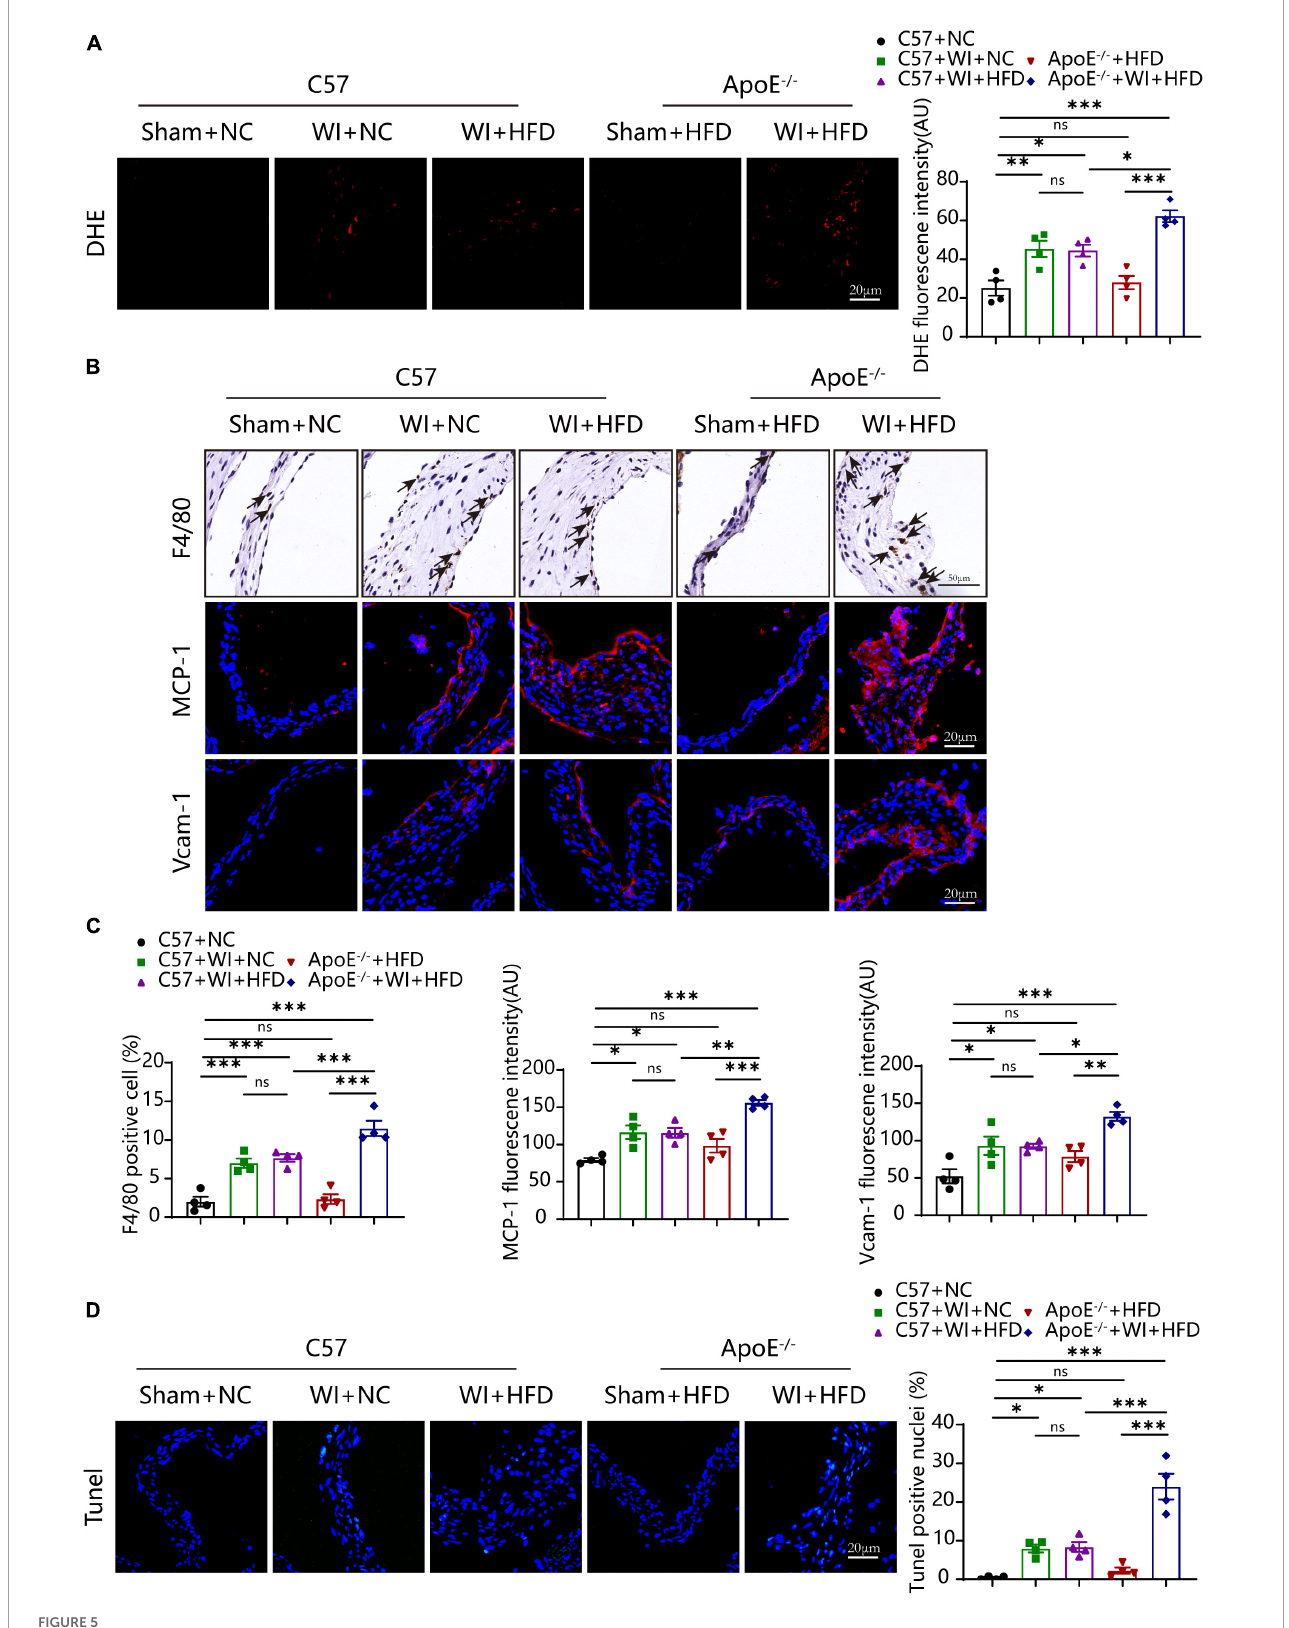
FIGURE5 Hyperlipidemia augmented advanced superoxide reaction and inflammation. Hyperlipidemia exacerbated superoxide (DHE, red, scale bar, 20 µ m); (A) after wire injury. Hyperlipidemia induced increment of macrophage accumulation beneath the leaflets endothelial (scale bar, 50 µ m) after wire injury and resulted in a pro-inflammatory valvular with increased expression of the chemokine MCP − 1 and Vcam − 1 (red, scale bar, 20 µ m; (B) . Quantitative analysis of macrophage (%), MCP − 1, and Vcam − 1 (C) , n = 4 per group. Hyperlipidemia exacerbated apoptosis (Tunel, green, scale bar, 20 µ m) after wire injury (D) , n = 4 per group. Results are mean ± SEM. Adjusted P values were provided in case of multiple groups. ns. indicates non-significant P value. * P < 0.05, ** P < 0.01, and *** P <